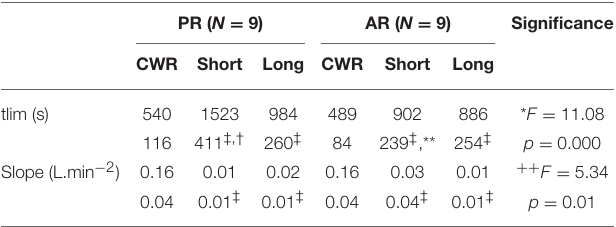
TABLE 2 | Mean ± SD values of the time to exhaustion (tlim) and the slope of the oxygen uptake response (Slope) during the constant-work-rate (CWR) and intermittent exercise conditions (Short and Long), for passive (PR) and active (AR) recovery groups. PR ( N = 9) AR ( N = 9) Significance